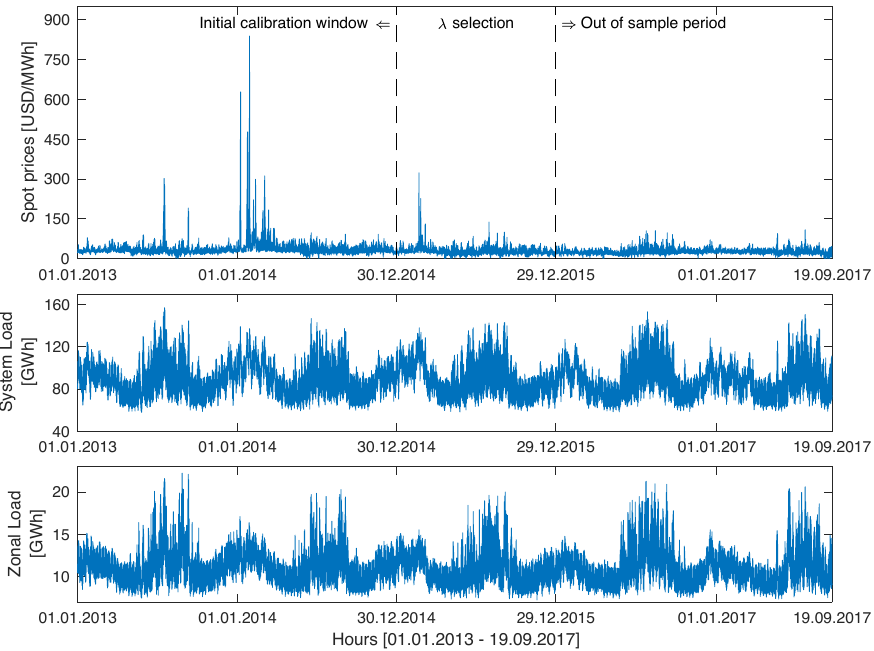
Figure 2. Hourly prices for the Commonwealth Edison (COMED) zone in the PJM market (top), hourly system load forecasts (middle) and hourly zonal load forecasts for the COMED zone (bottom) for the period 1 January 2013 to 19 September 2017. The dashed lines have the same meaning as in Figure